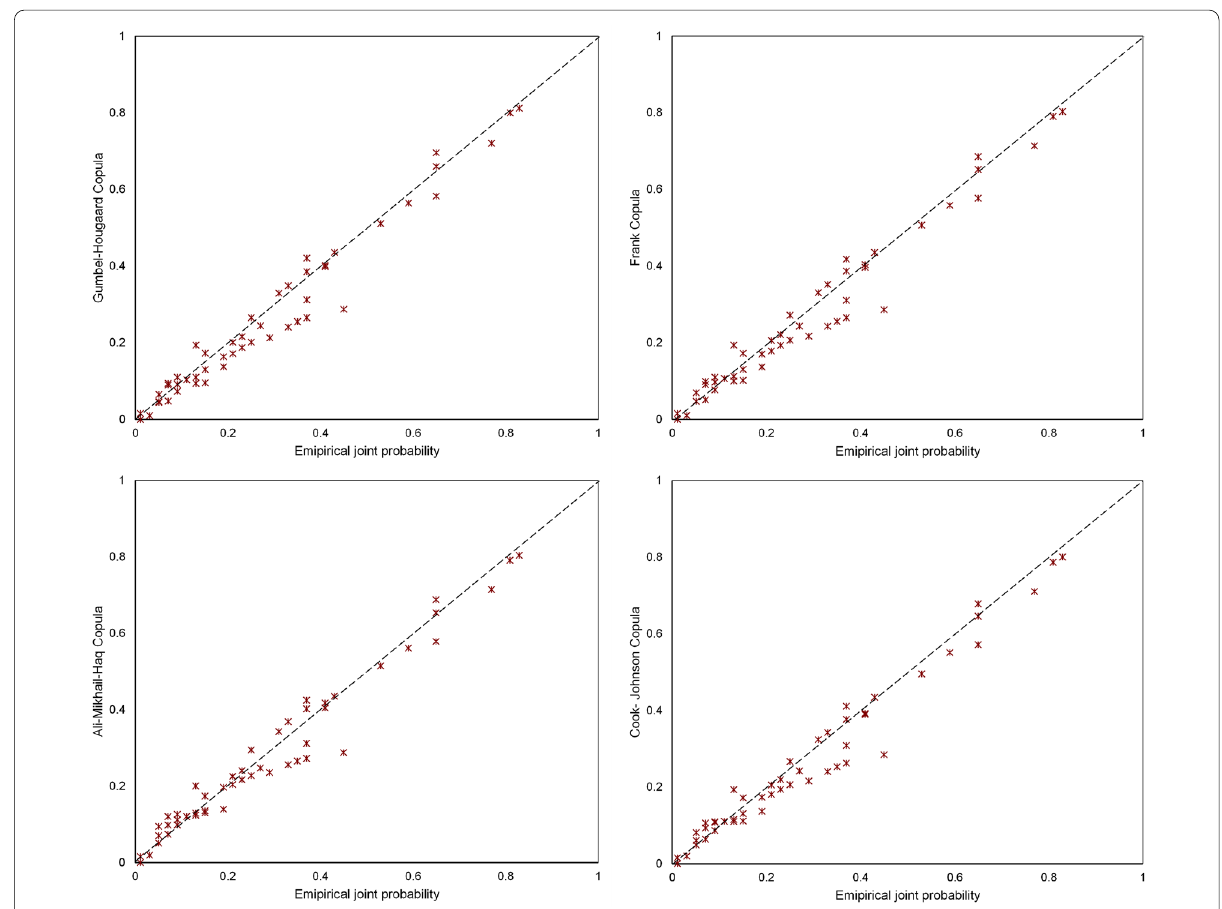
Fig. 9 Comparison of joint cumulative probabilities obtained through empirical equation and copula for flood peak and duration